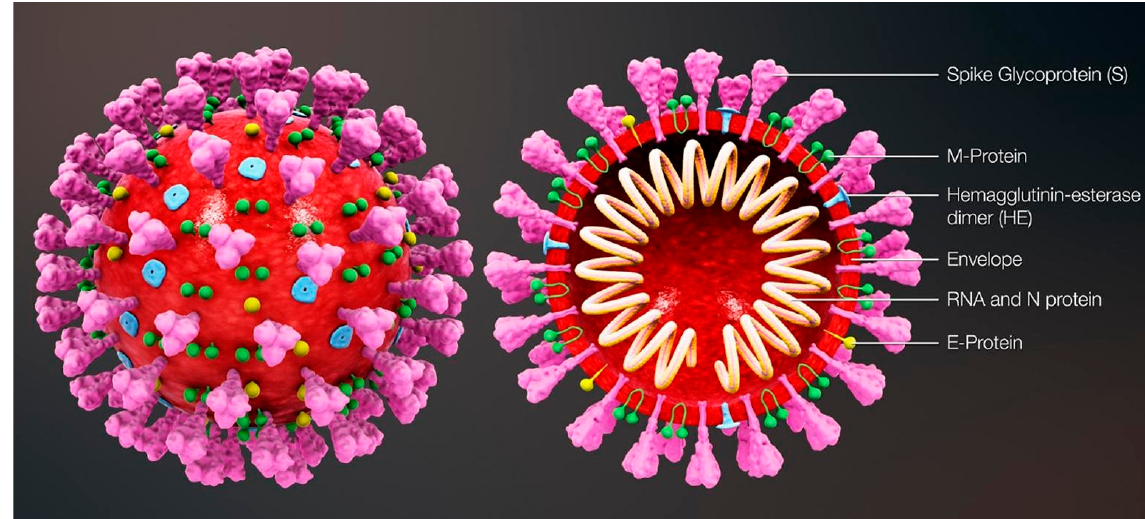
Figure 1. Structure and components of SARS-CoV-2. Reproduced with permission from Ref. [1]. Copyright 2022 Elsevier.